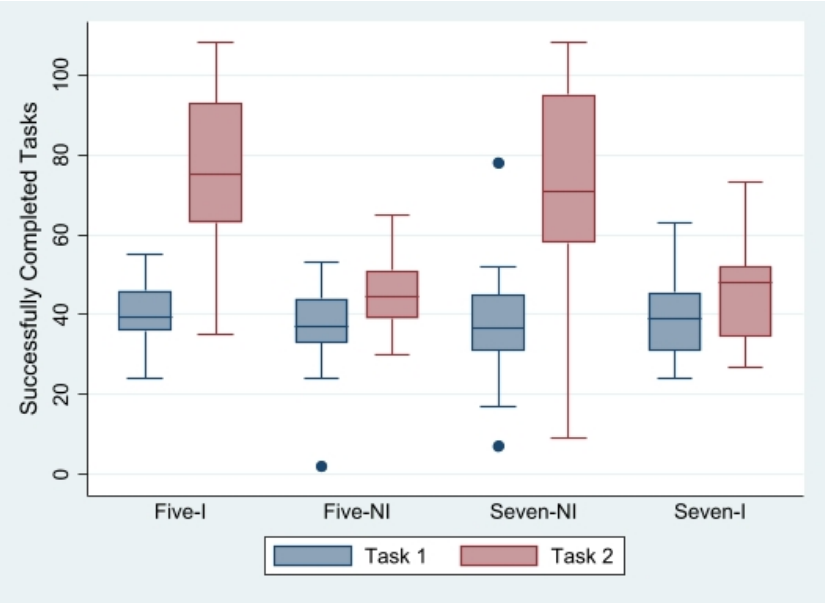
Figure 3. A box and whisker plot of subject effort in both Task 1 and Task 2 by Treatment.